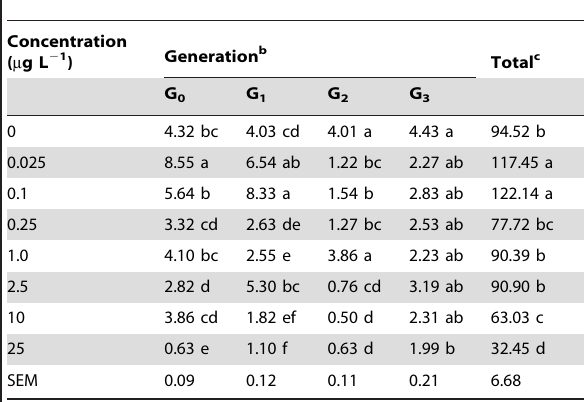
Table 2. Least-squares means of multigenerational fecundity a following continuous exposure of M. persicae to sublethal concentrations of imidacloprid.